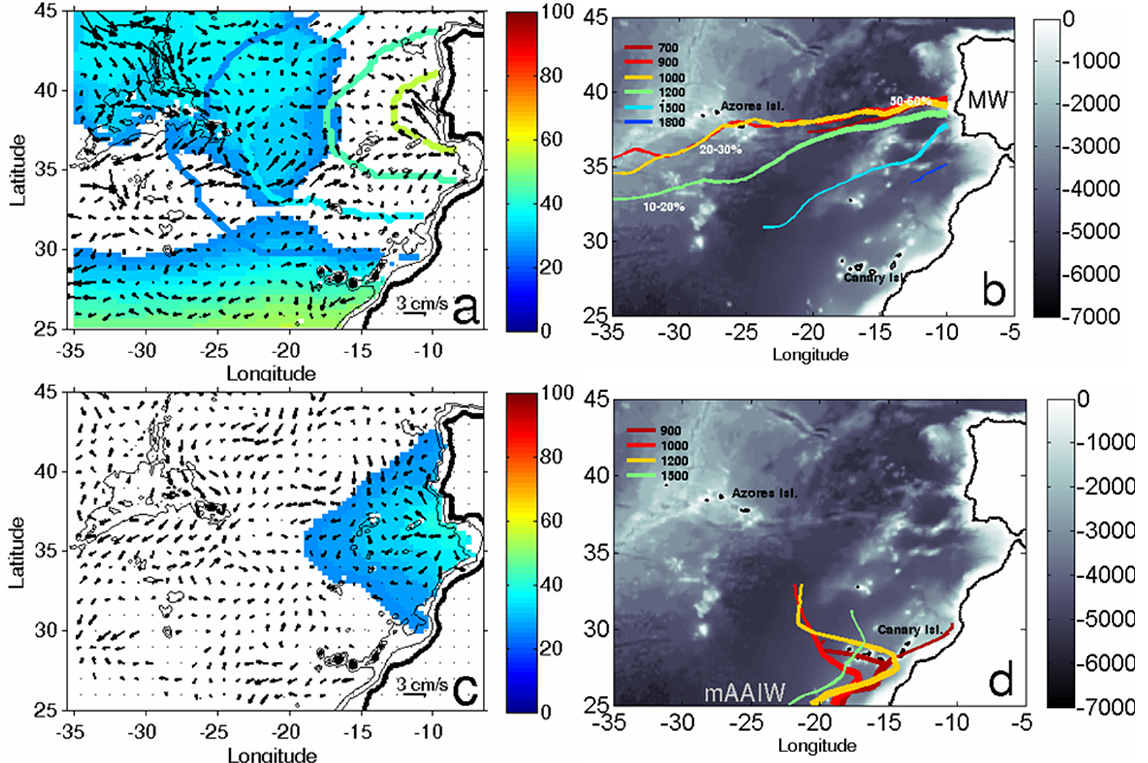
Figure 12. (a) Source water type contents (%) at 27.75kgm − 3 (from 950 to 1200m depth): SAIW (northwest, colour), mAAIW (south, colour) and MW (west, contours). Only source water type concentrations over 25% are presented. Current vectors at 1100m depth are overlaid. (b) Paths of mAAIW at different depth levels based on variation of the source water type contents. (c) MW contents (%,colour) at 27.88kgm − 3 (from 1350 to 1550m depth). Only the source water type concentrations over 25% are presented. Current vectors at 1500m depth are overlaid. (d) Paths of MW at different depth levels based on variation of the source water type contents. In panels (b) and (d) : dark red is 600m, red – 900m, yellow – 1000m, green – 1200m, light blue – 1500m, thin dark blue line – 1800m. The line thickness in (d) demonstrates MW contents, which varies from 30–60% in the east to 10–20% in the west of the